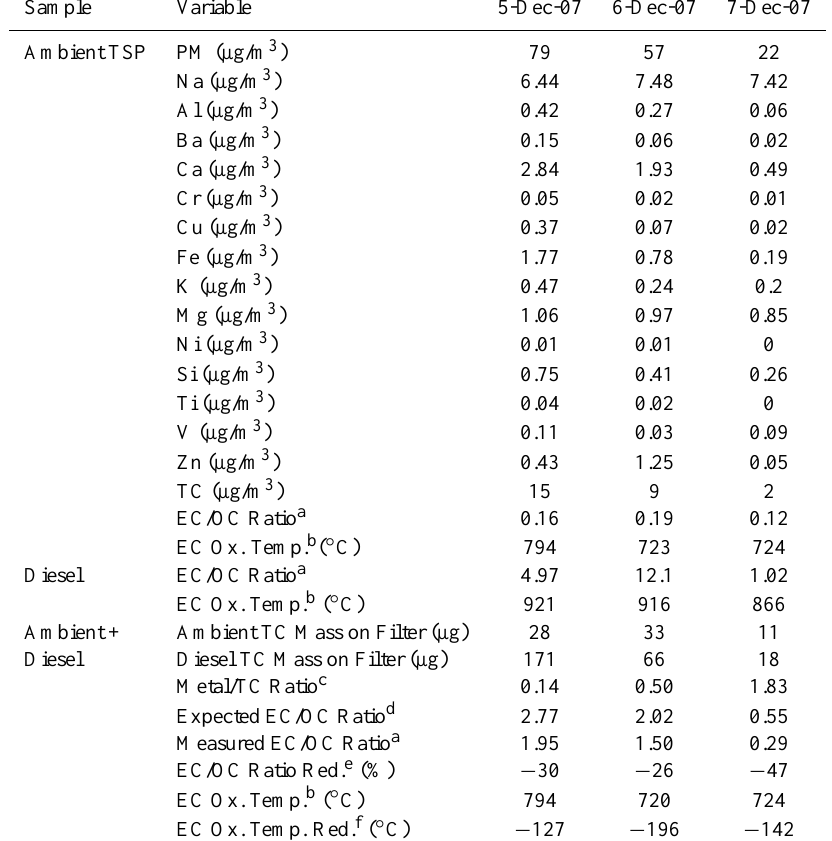
Table 1. Chemical composition and carbon characteristics of ambient TSP, diesel, and co-deposited ambient and diesel particles.